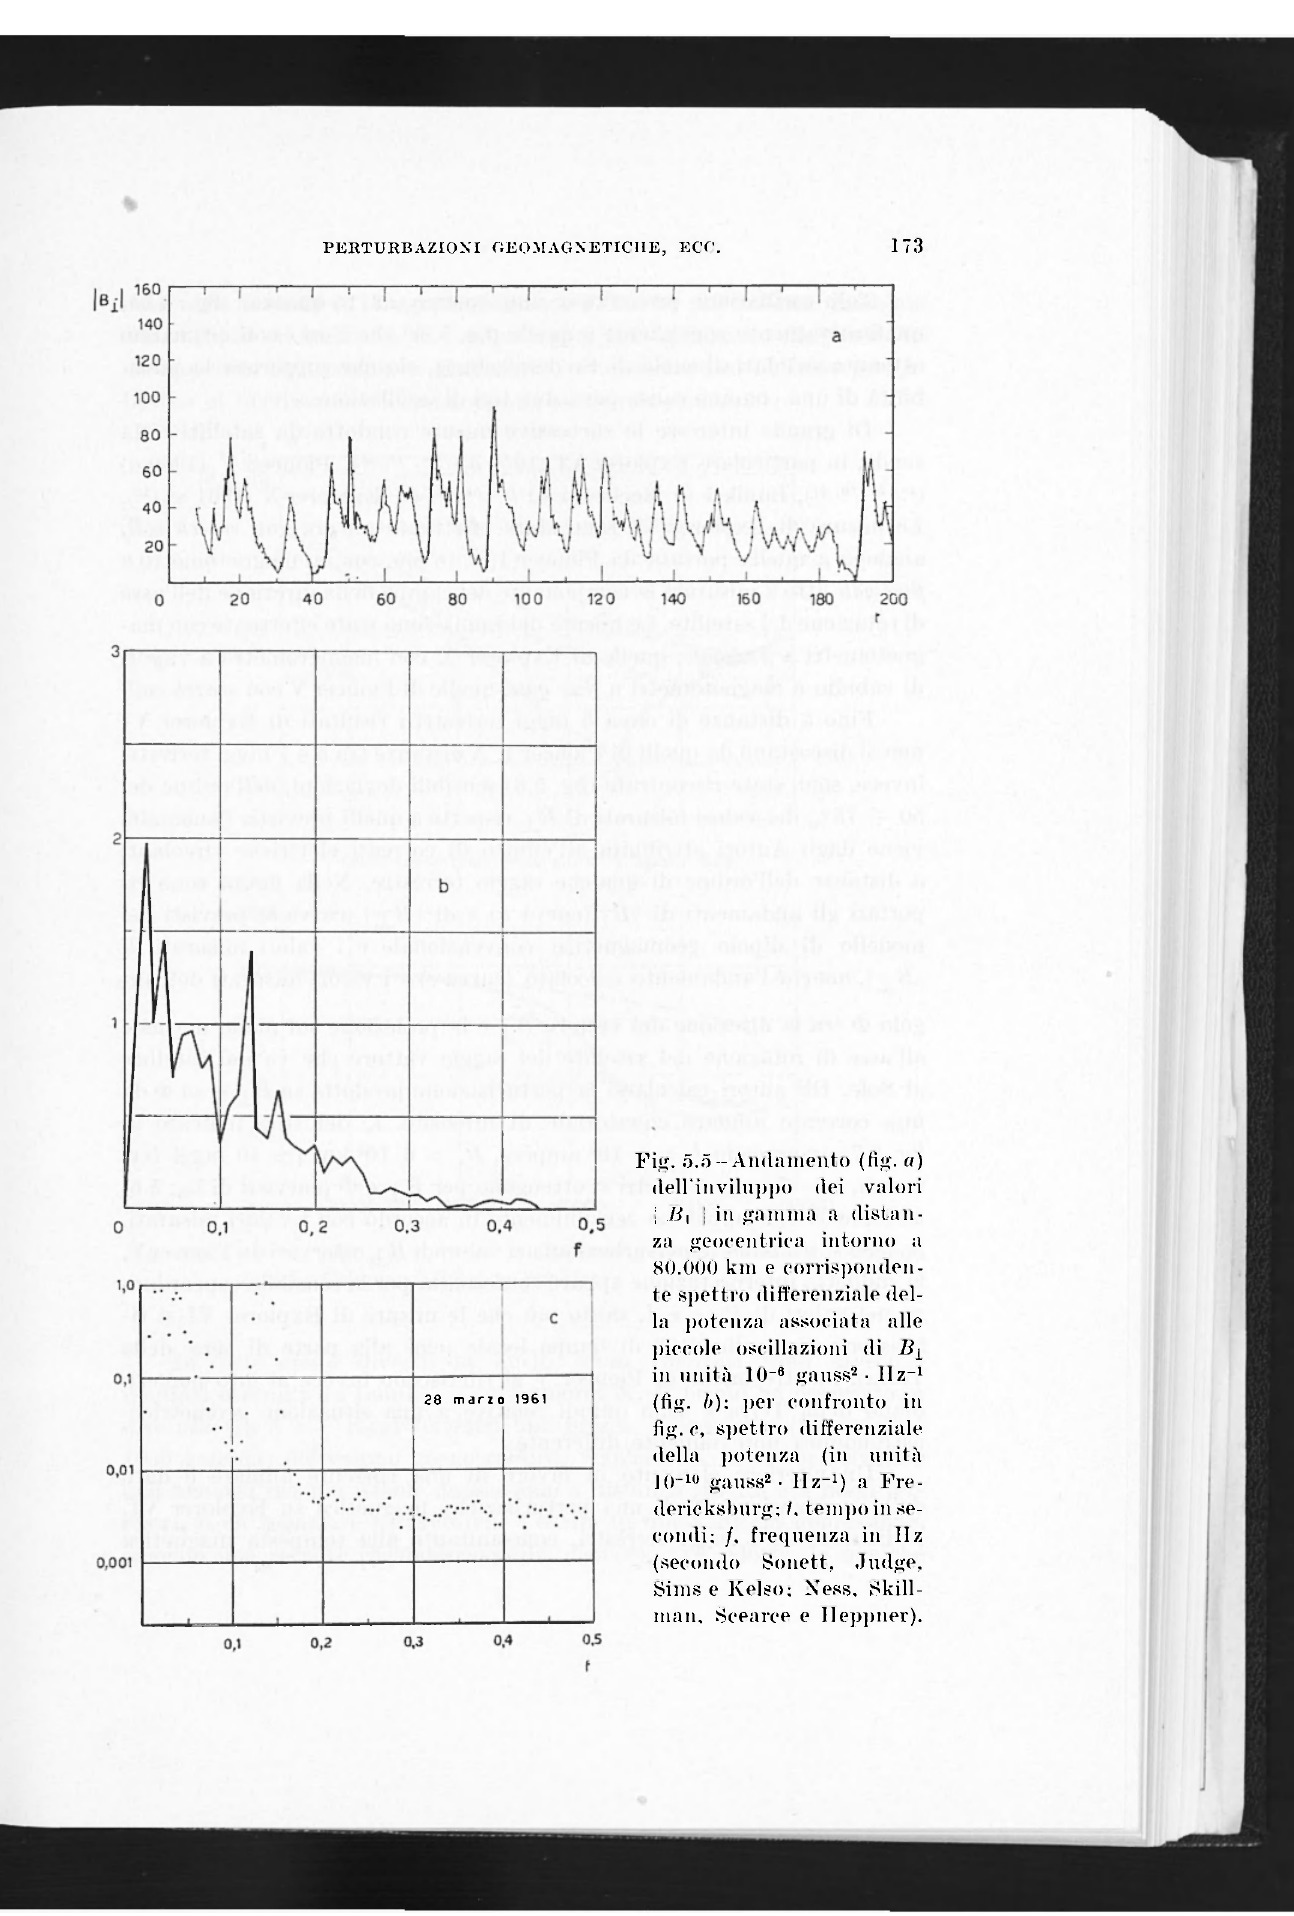
(fig. li): per confronto in fig. c, spettro